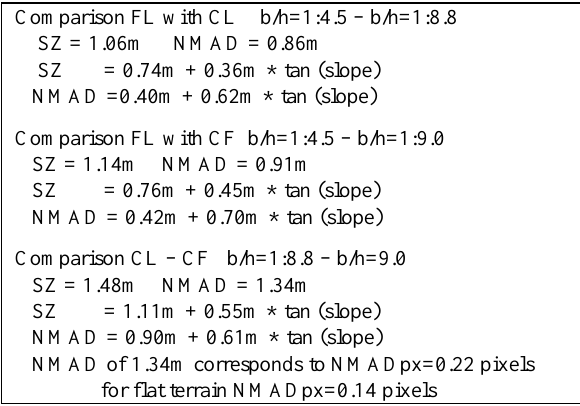
Table 7: Discrepancies between Pleiades height models based on different image